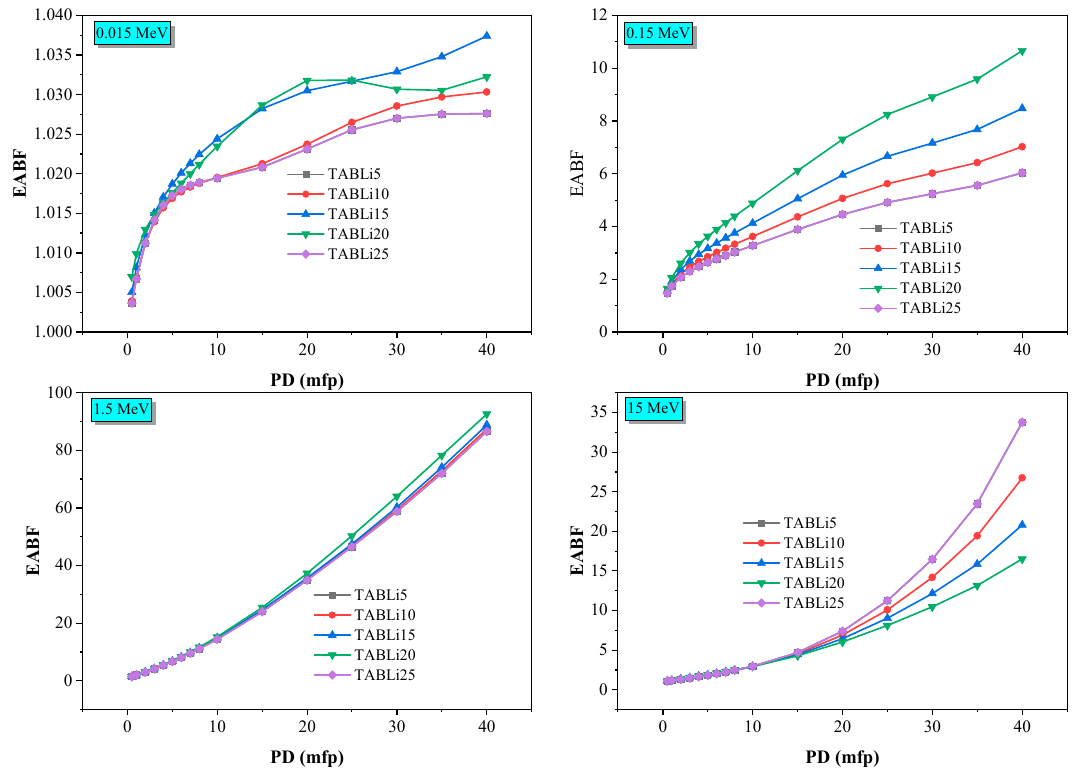
Figure 18. The EABF dependent on the penetration depth values (PD) at some fixed energies.